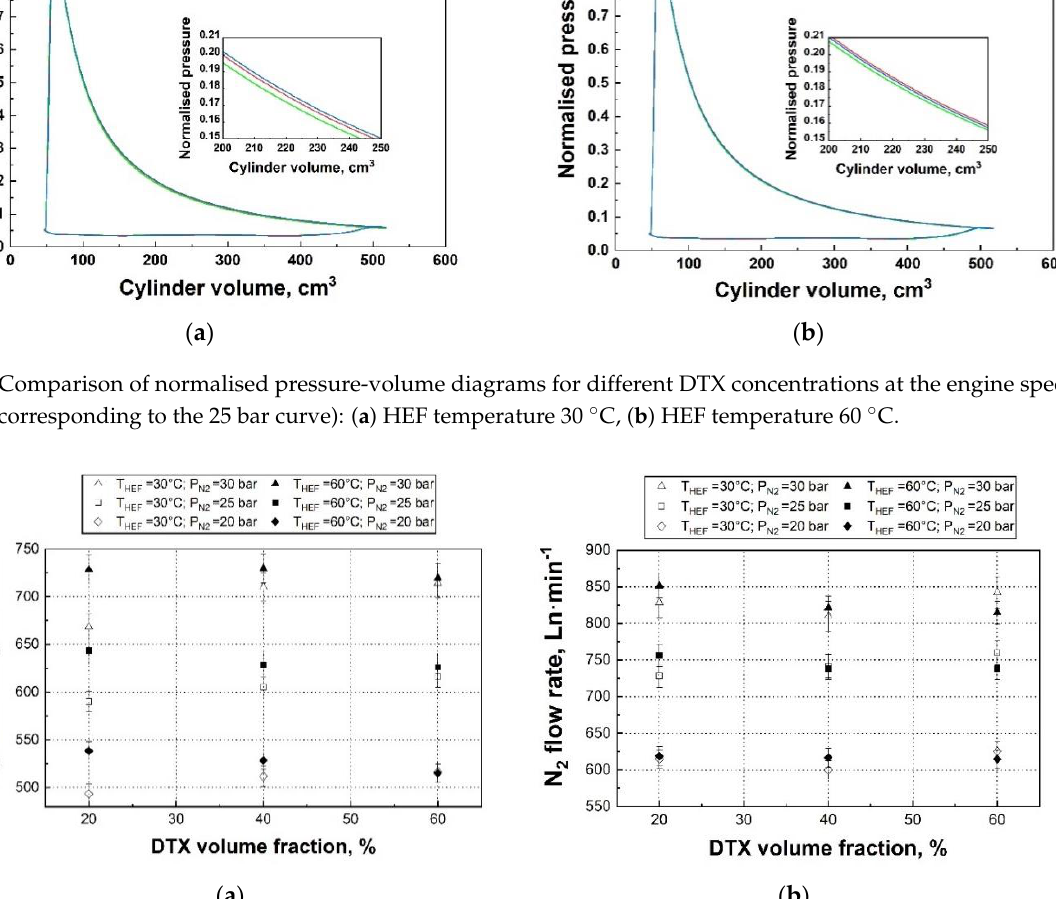
Figure 9. Nitrogen consumption rates at different operating conditions: ( a ) 𝑁 = 600 rpm and ( b ) 𝑁 = 700 rpm.